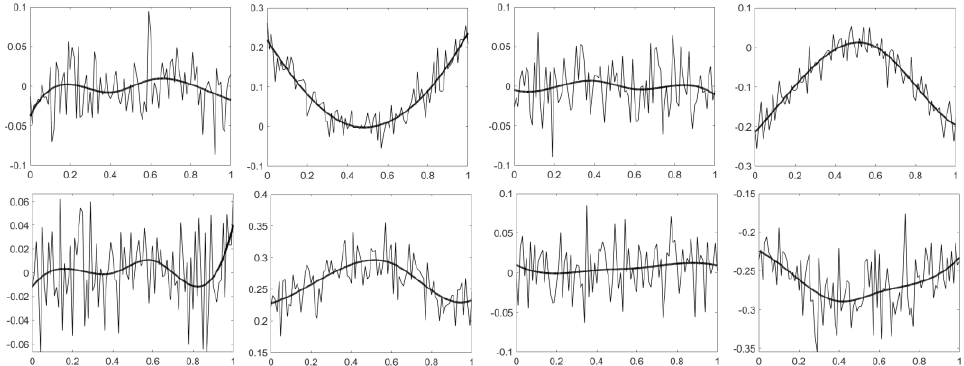
Figure A2. Examples cubic spline fits (thicker lines) to the MC data (thinner lines) for the Blink dataset. From to left to right: first column, y -positions of the 1st point (left corner of the eye); second column, 5th point (middle upper boundary); third column, 9th point (right corner of the eye); and fourth column, 13th point (middle lower boundary). Upper row is for the “blink” group, shown by y going to zero for points 5 and 13 at time 0.5 (arbitrary units of time); lower row is for the eyes widening/“surprise” group, shown by y increasing in magnitude for points 5 and 13 at time 0.5.